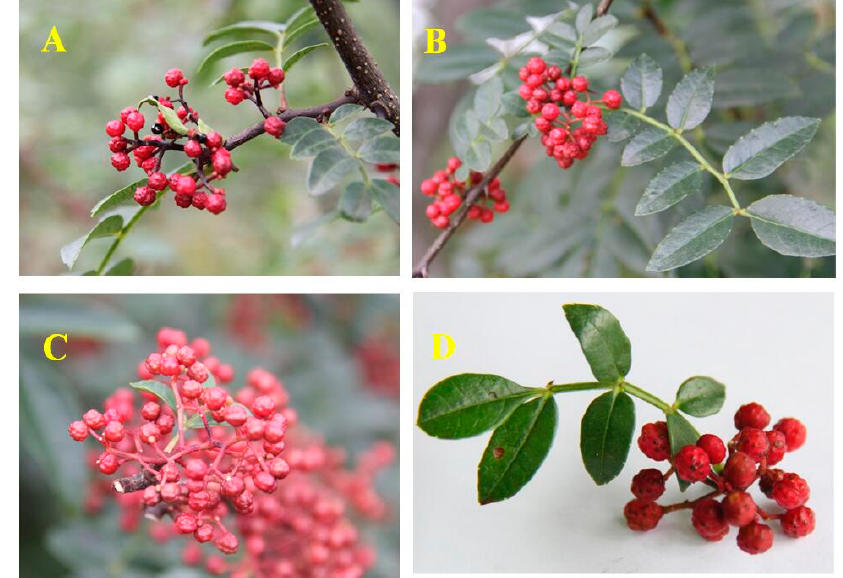
Figure 1. The stem ( A ); the leaves ( B ) and the pericarps ( C , D ) of Z. bungeanum .